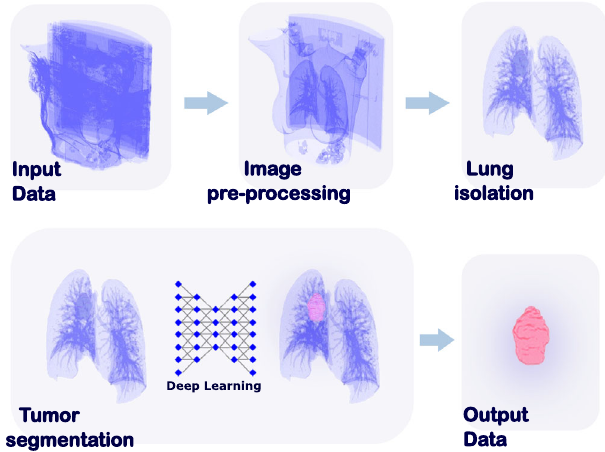
Fig. 1 Graphic representation of the major steps in the proposed work fl ow. Proposed work fl ow is fully automatic and due to preprocessing step can handle variability in CT